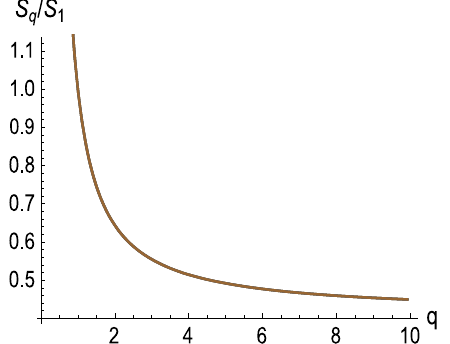
Fig. 3 S q / S 1 as a function of q for various C . Here λ = 0 . 08 and red, green, blue and brown curves correspond to C =0, − 1 / 2, − 3 / 2 and − 2 respectively. For this plot, we have chosen R = 1, δ = 10 − 4 and